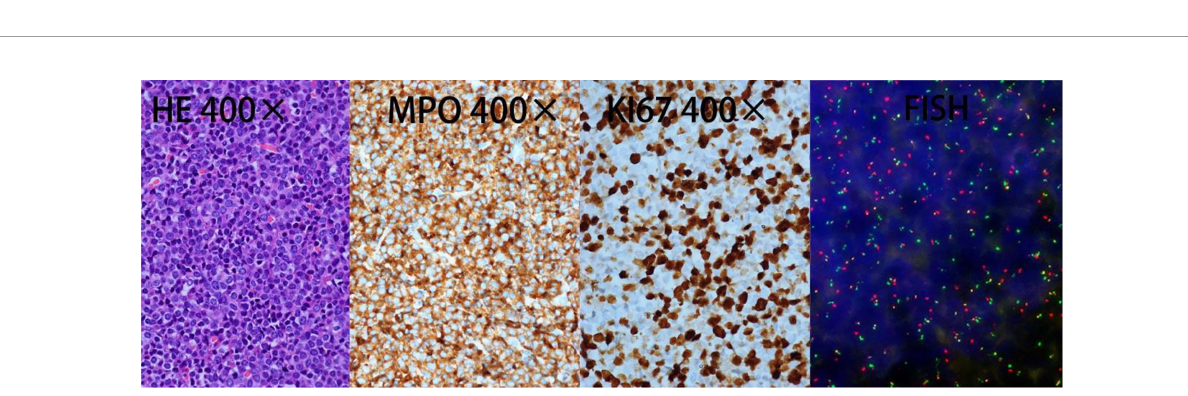
FIGURE 2 | Histological analysis of the spine biopsy. HE, hematoxylin – eosin stain; MPO, myeloperoxidase positivity; KI67, proliferation index. FISH analysis performed on excised tumor demonstrated PML-RAR a